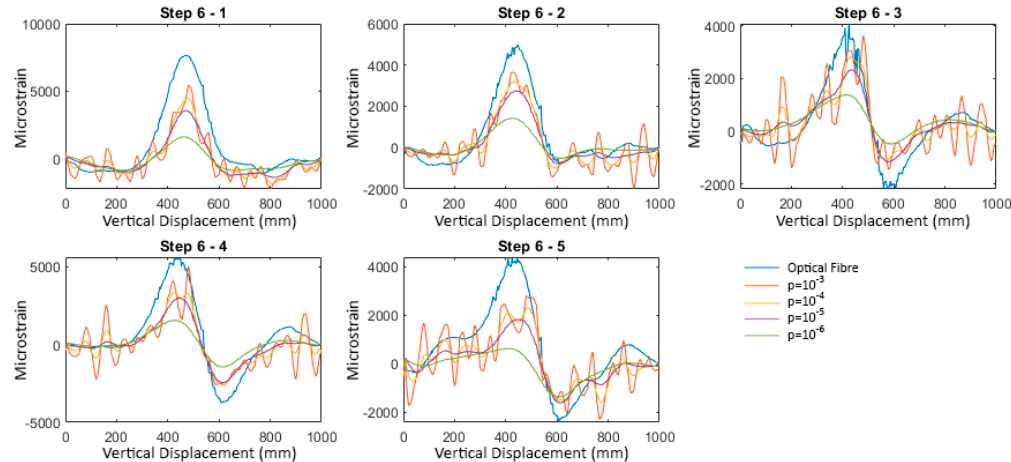
Figure 13. OOP deformation test: Change in strain of Step 6 relative to the preceding tests with different p and measured by the optical fibre along the vertical line at 800 mm horizontally.